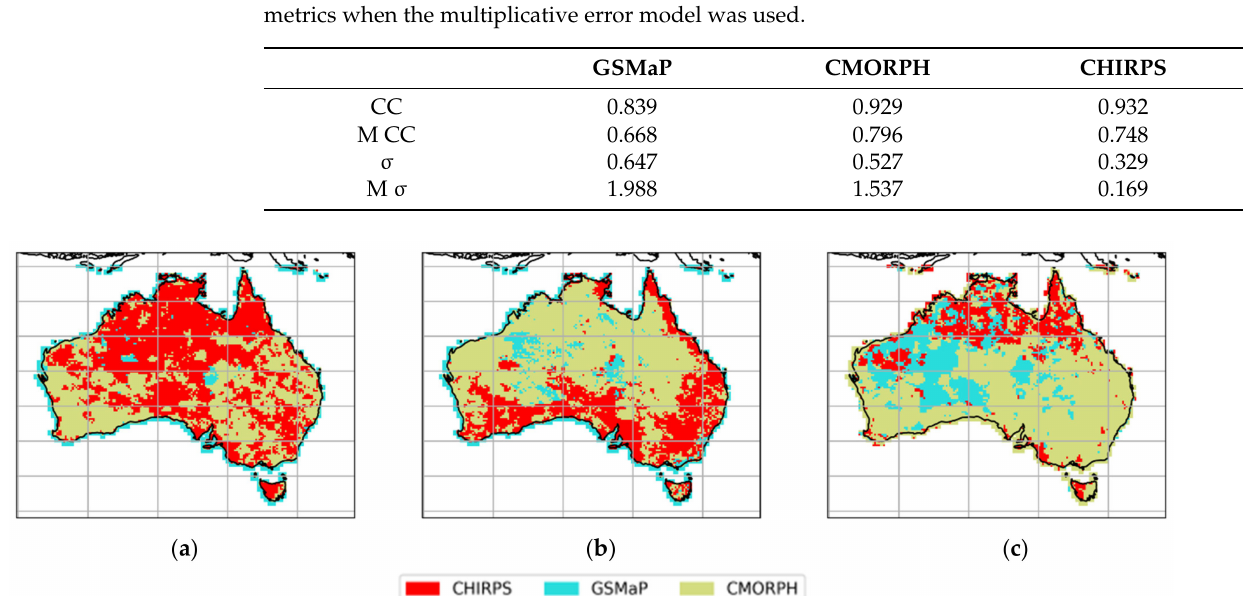
Figure 6. Distribution of pixels with highest ( a ) CC for triple collocation, ( b ) CC for multiplicative triple collocation, and ( c ) KGE against MSWEP